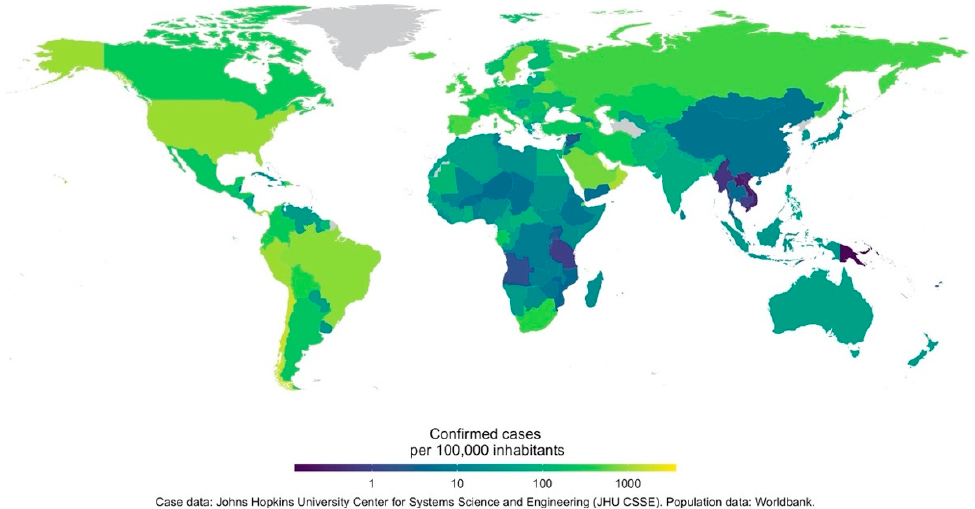
Figure 1. The number of confirmed COVID-19 cases as of 12 July 2020. Data are shown as the number of cases per 100,000 individuals. COVID-19 case data are from Johns Hopkins University Center for Systems Science and Engineering. The world population data are from the World Bank.